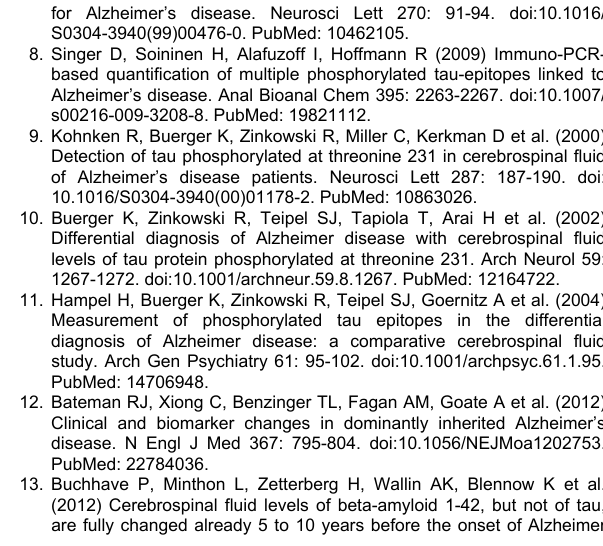
samples from healthy control subjects (black bars) or AD patients (red bars) were immunodepleted with tau antibody mean ± SEM from 3 determinations. Dashed lines indicate the assay LLQ corrected for CSF dilution. Figure S6. Spike recovery in ptau ELISAs. Pooled CSF samples were treated with pT181 or pT231 spikes ranging from 12.5-200 pg/ml. Spiked samples and a matching untreated